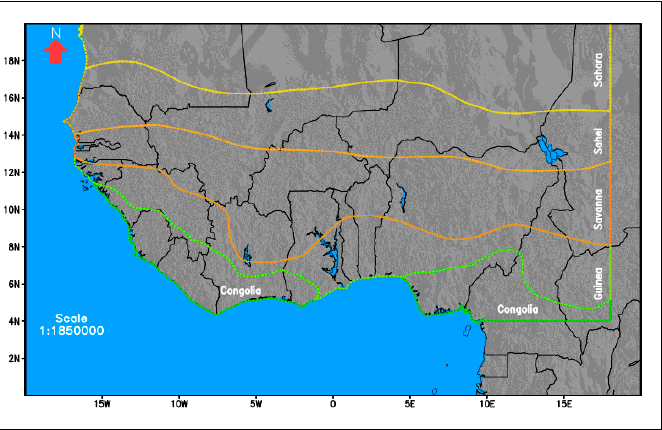
Figure 1. Map of West Africa showing five bioclimatic zones (adapted from [3] and [9,10]) .